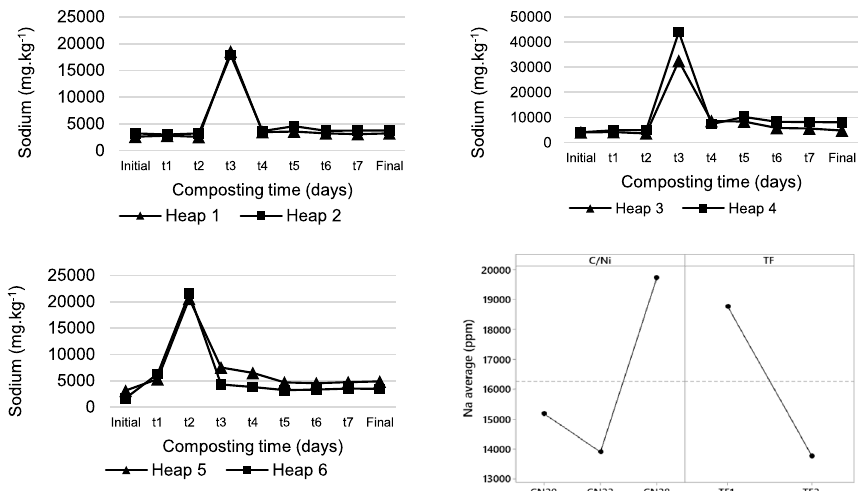
Fig. 4 Evolution of sodium content during composting for the six heaps and factors’ effect